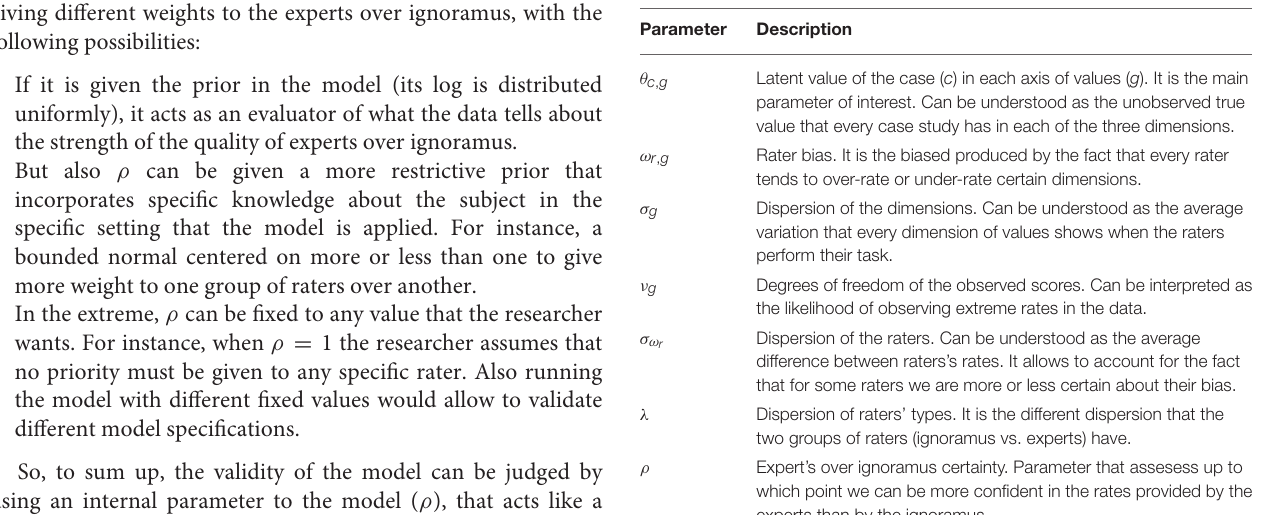
parameter to assess the validity of different model specifications TABLE 3 | Parameter labels and their